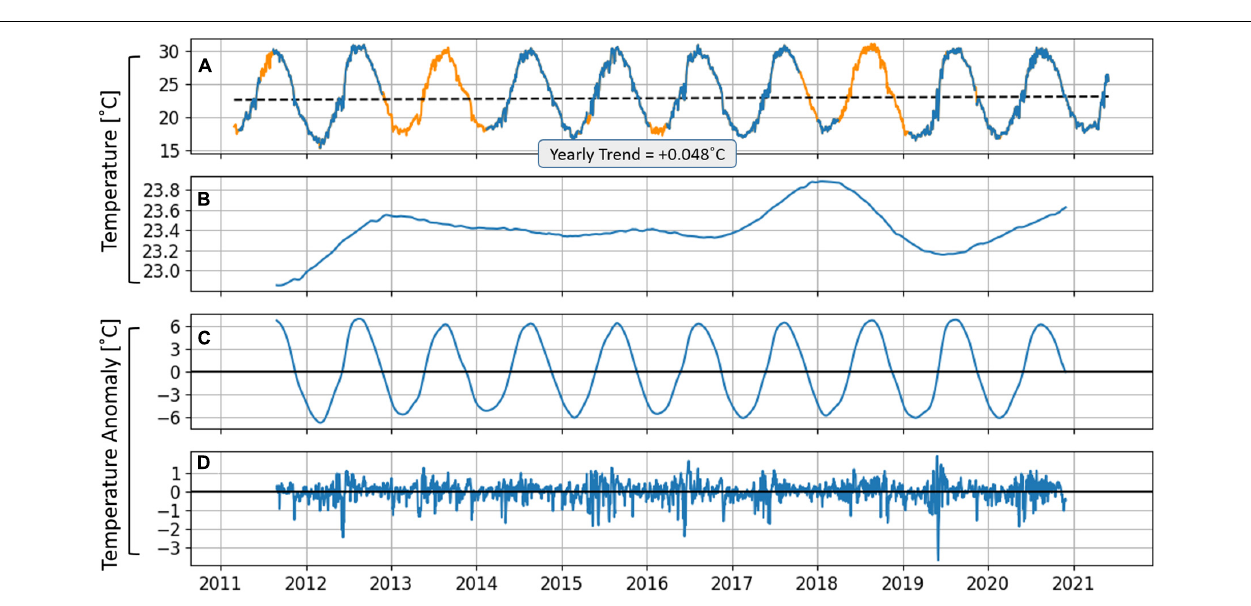
Frontiers in Marine Science |